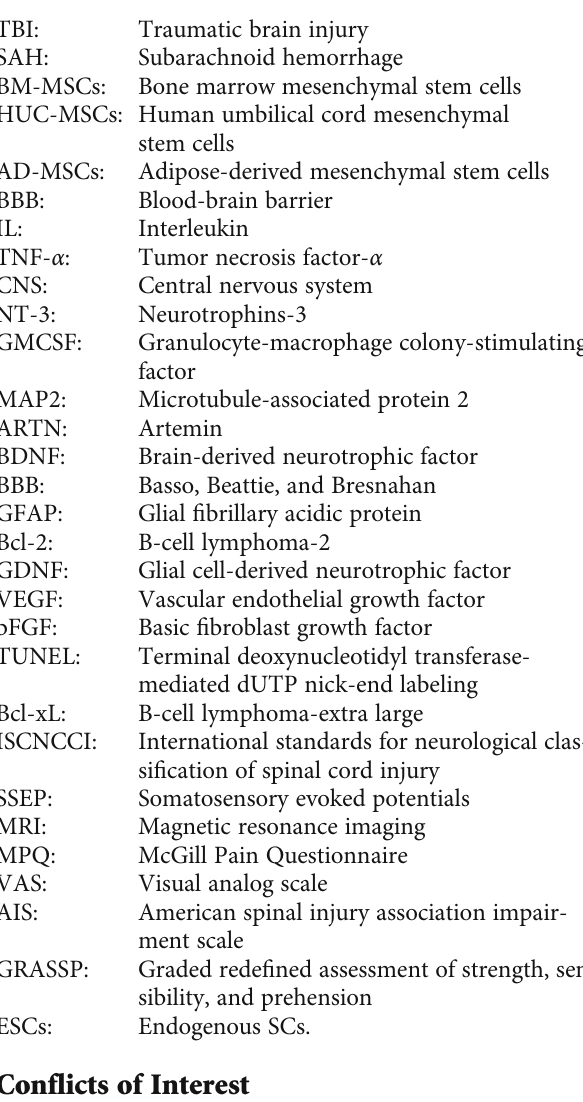
Supplemental Table 1: clinical trials of SCs in the treatment for SCI. (Supplementary